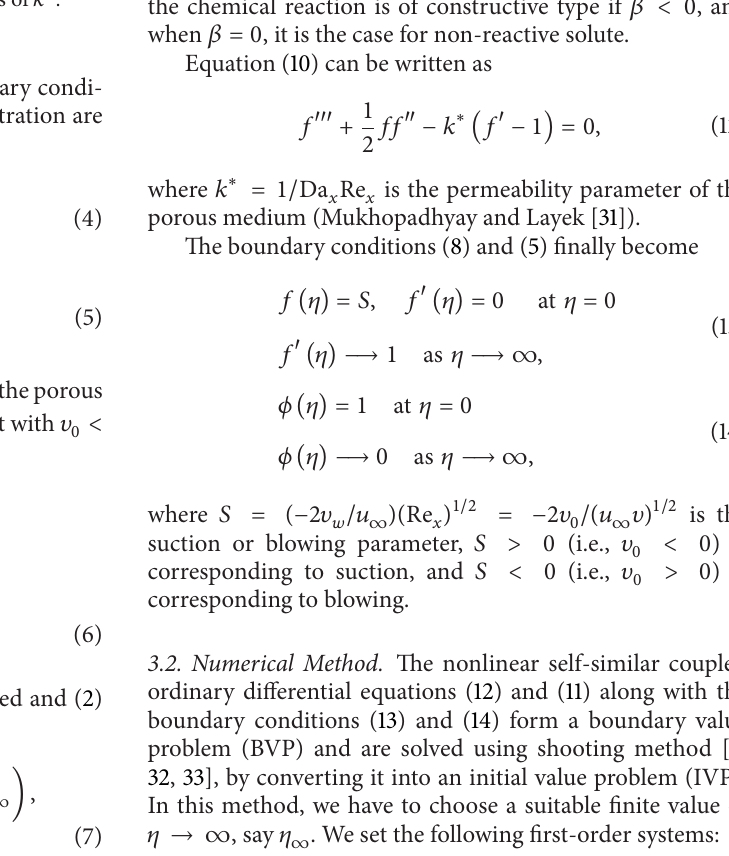
Figure 2: Velocity profiles 𝑓 󸀠 (𝜂) for different values of 𝑘 ∗